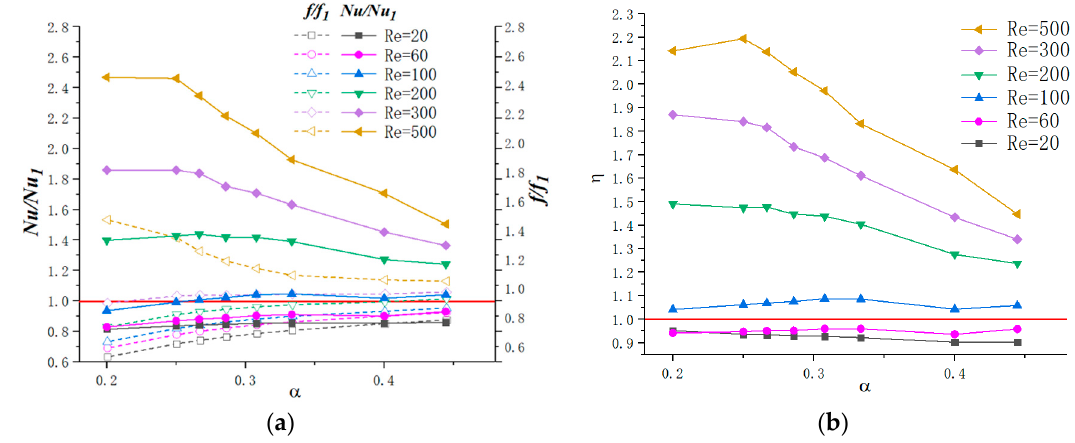
Figure 15. Variation of f/f 1 , Nu/Nu 1 and ƞ with α for different Reynolds number. ( a ) f / f 1 , Nu / Nu 1 , ( b ) ƞ .